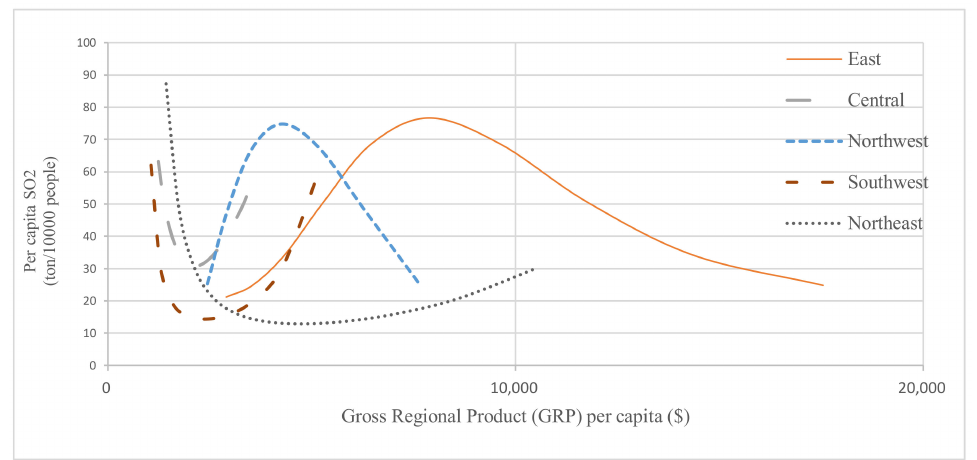
Figure 2. Pollution-Growth Patterns at Five Regions in